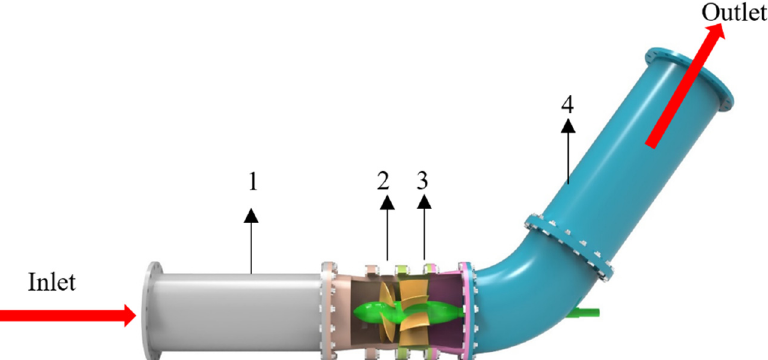
Figure 1. Overall 3D model drawing.1. Inlet pipe, 2. Impeller, 3. Guide vane, and 4. Outlet pipe .